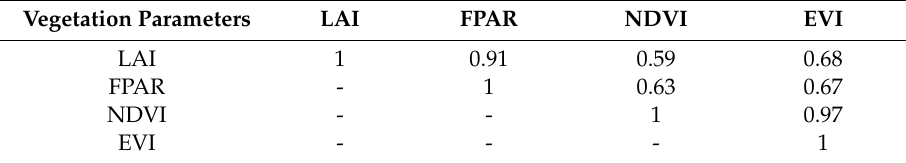
Table A2. Pearson correlation coe ffi cient between the vegetation